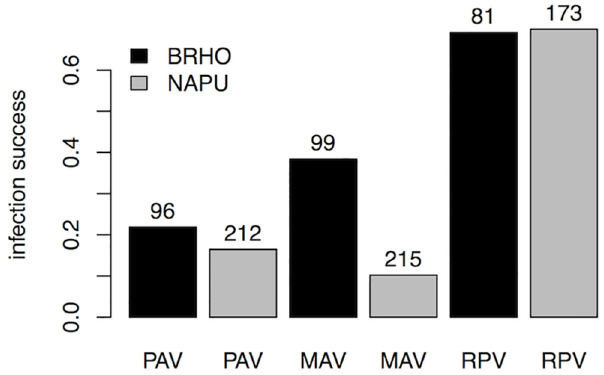
Fig 4. Fraction of inoculations that were successful for PAV, MAV, and RPV in Bromus hordeaceus (black bars) and Nassella pulchra (gray bars). Numbers above bars indicate sample